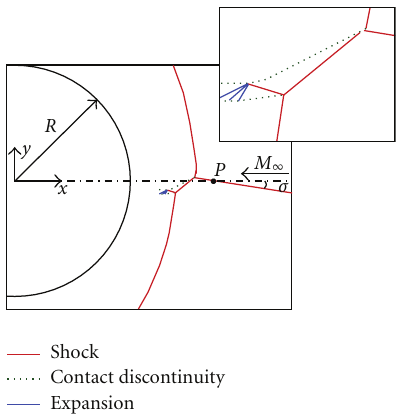
Figure 6: Type IV shock-shock interaction ( M ∞ = 10): test case definition and flow